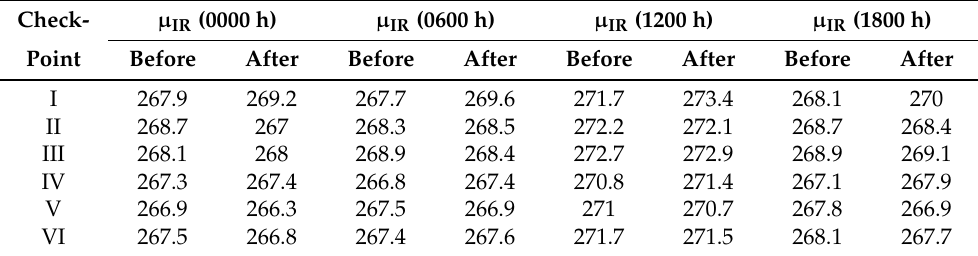
Table 6. IR channel mean BT values (K) before and after the